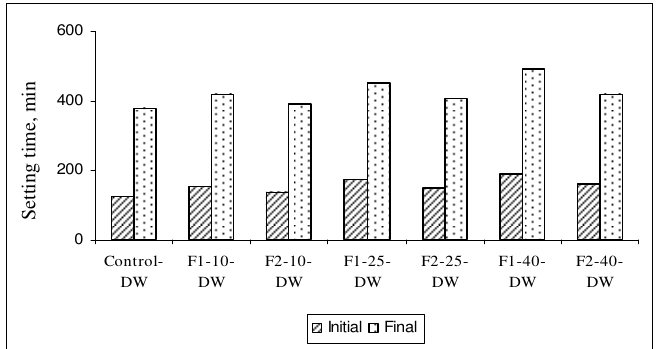
Figure 1 . Setting time of control, F1 and F2 fly ash blended cement